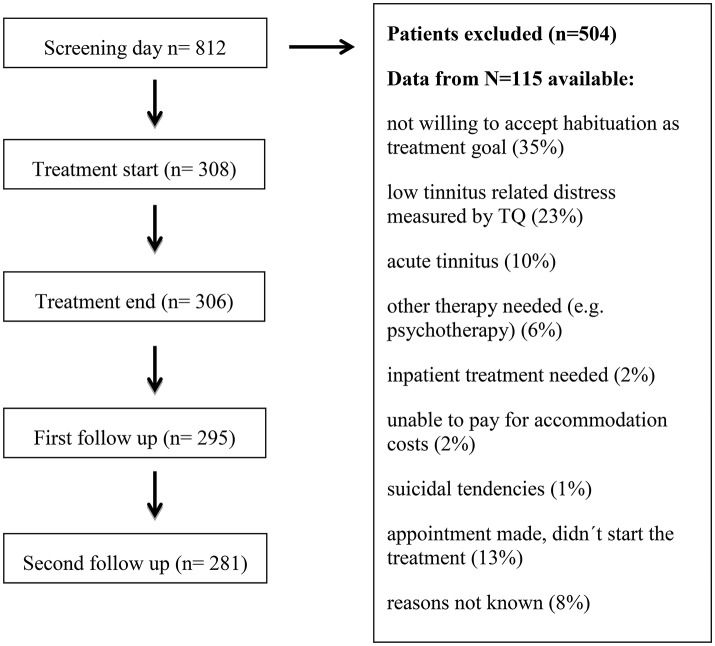
Patient flow chart.